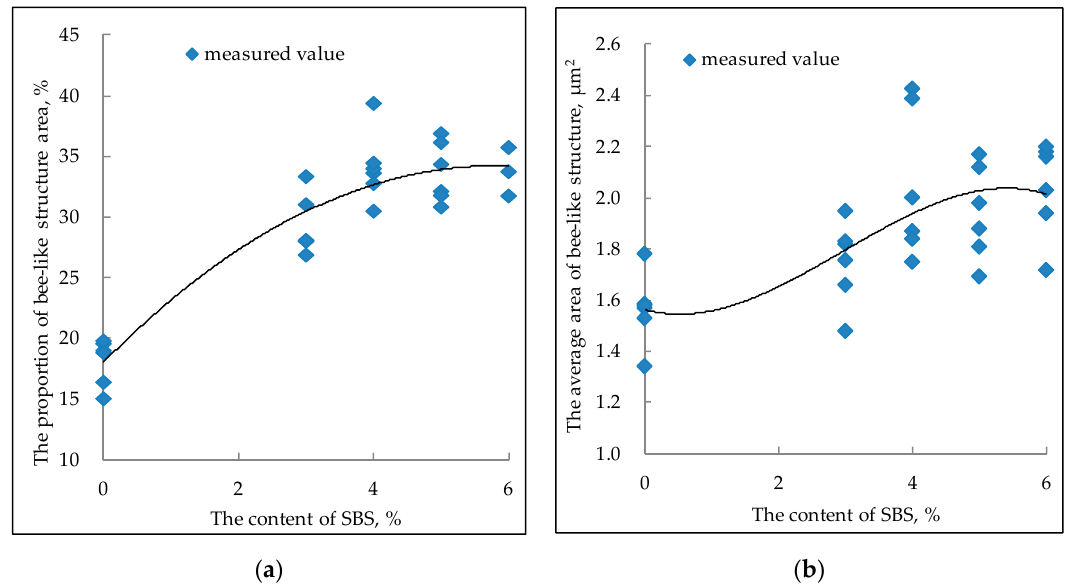
Figure 6. Relationship between SBS content and bee ‐ like structure area (( a ) the proportion of bee ‐ like structure area; ( b ) the average area of bee ‐ like structure).